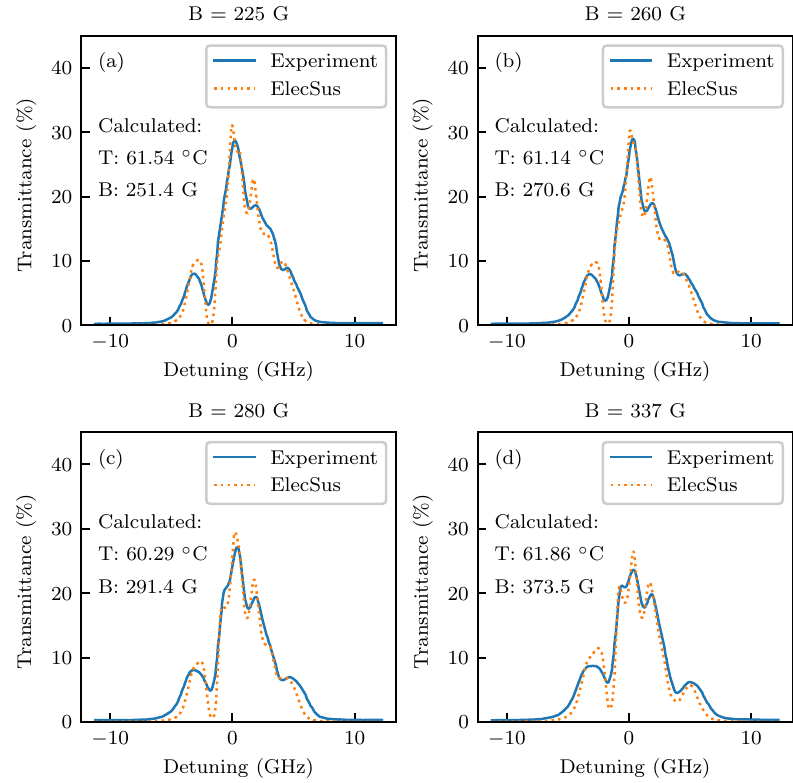
Figure 5. The measured transmittance spectra (blue, solid) and the fitted transmittance spectra (orange, dashed) at the discharge current of 18 mA and the magnetic field from 225 G to 337 G. The fitted equivalent temperatures (T) and magnetic fields (B) are listed on each subfigure. ( a ) The measured and the fitted transmittance spectra at the magnetic field at 225 G, and the fitted equivalent temperature is 61.54 ◦ C and the fitted magnetic field is 251.4 G; ( b ) The measured and the fitted transmittance spectra at the magnetic field at 260 G, and the fitted equivalent temperature is 61.14 ◦ C and the fitted magnetic field is 270.6 G; ( c ) The measured and the fitted transmittance spectra at the magnetic field at 280 G, and the fitted equivalent temperature is 60.29 ◦ C and the fitted magnetic field is 291.4 G; ( d ) The measured and the fitted transmittance spectra at the magnetic field at 337 G, and the fitted equivalent temperature is 61.86 ◦ C and the fitted magnetic field is 373.5 G.